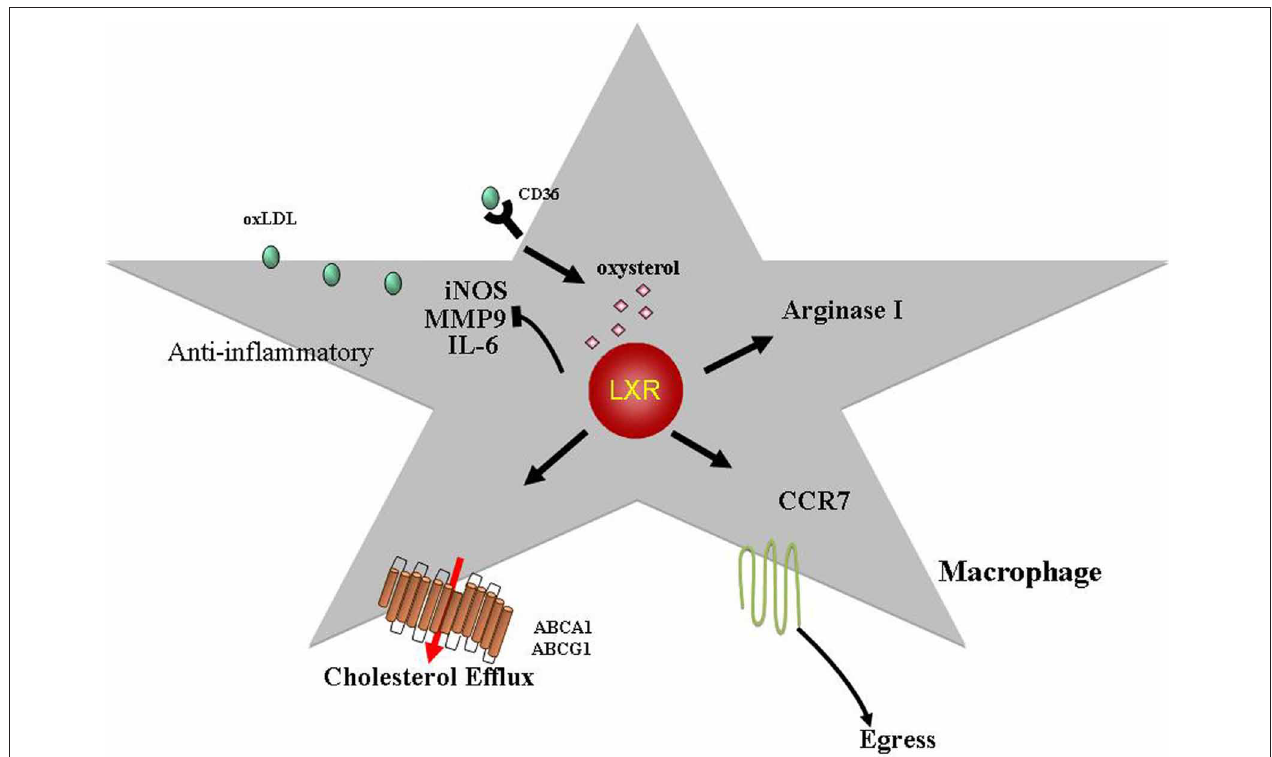
FIGURE 2 | LXRs exhibit anti-atherogenic properties. LXR ligands, oxysterols, activate the LXR transcription factors (LXR α , LXR β ) leading to increased expression of targets such as ABCA1 and ABCG1. This is a key step in promoting cholesterol efflux from macrophages. LXRs have also been shown to inhibit expression of inflammatory mediators such as iNOS, MMP9, and IL6. Recently, it was demonstrated that LXR α activation can induce arginase I (M2 macrophage marker) expression suggesting that LXRs can skew macrophages toward a M2